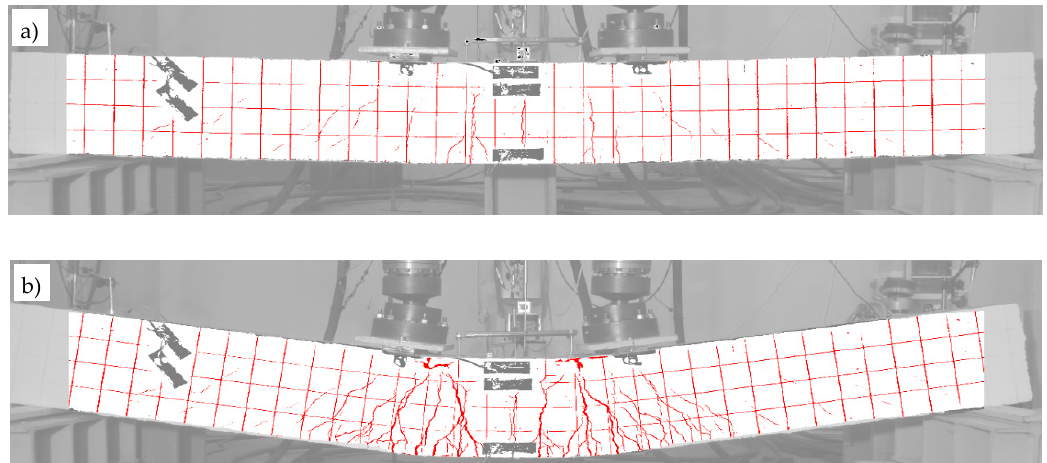
Figure 25. Views of the cracking of beam #1: ( a ) the neutral axis reaches the layer boundary according to Equation (10) ( z c = 7 cm); ( b ) the actuators reach the maximum travel range. In order to increase the clarity of the figure, the instrumentation and the places where the strain gauges were glued are painted in grey, and the positioning grid (10 cm mesh) and the cracks are marked in red.